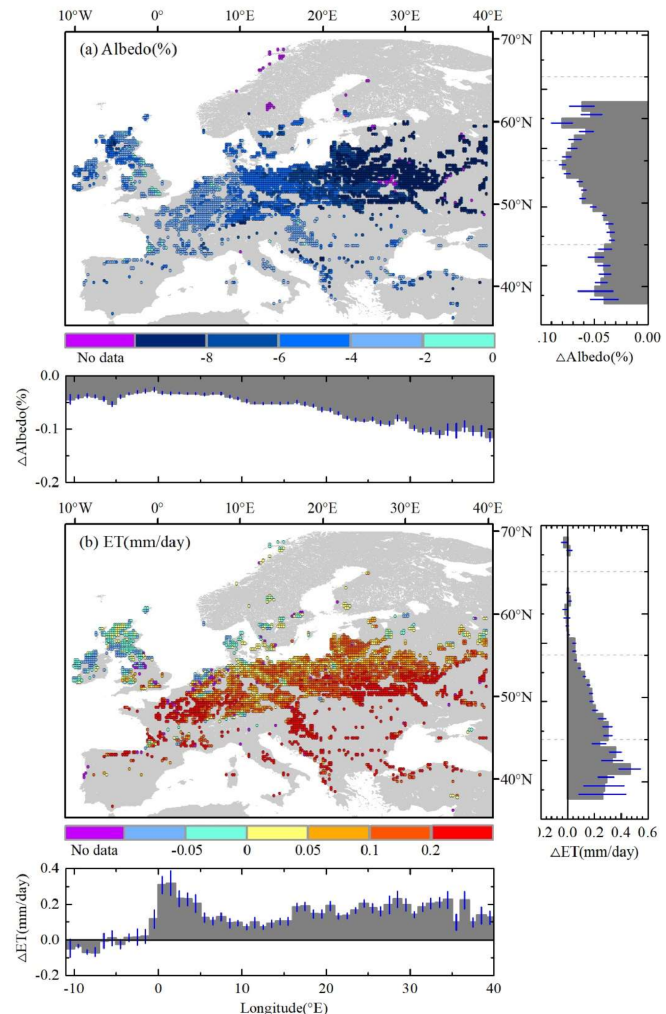
Figure 9. The spatial distributions of annual mean ( a ) albedo (%) and ( b ) ET differences (forest minus open land) in Europe. The periods used to analyze albedo and ET differences are 2003–2016 and 2003–2014, respectively. The below and right small panels for each difference show the longitudinal and latitudinal zonal averages for every 1 ◦ bin. The blue lines represent the 95% confidence interval (CI) estimated by the t